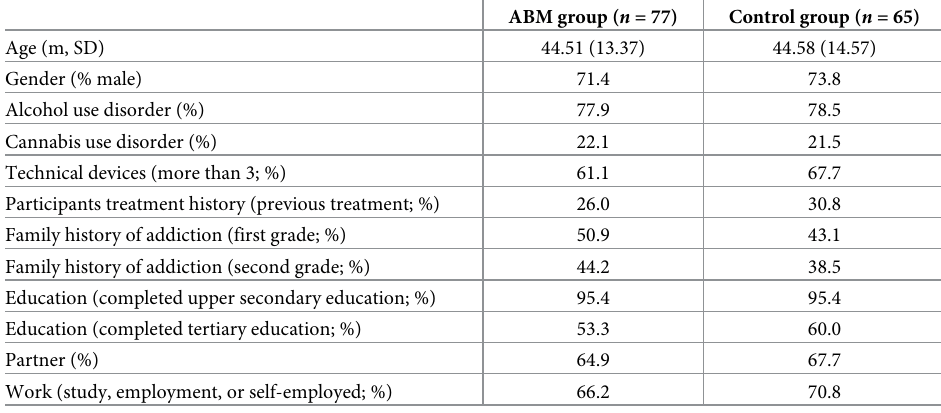
Table 3. Descriptives of sociodemographic information per